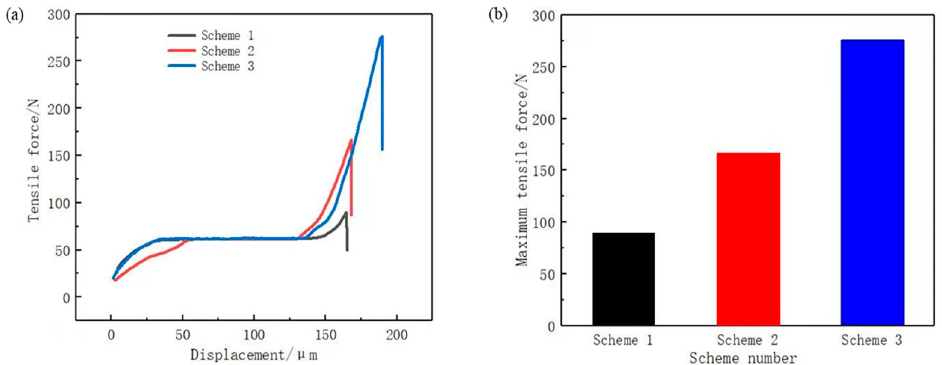
Figure 9. ( a ) tensile force curve; ( b ) maximum tensile force.